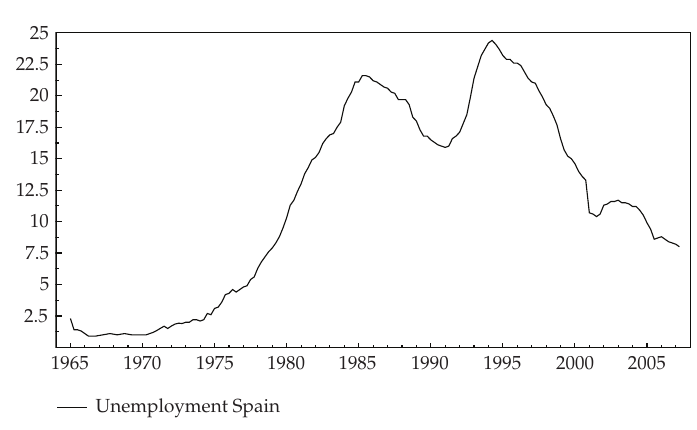
Figure 1: Spanish unemployment